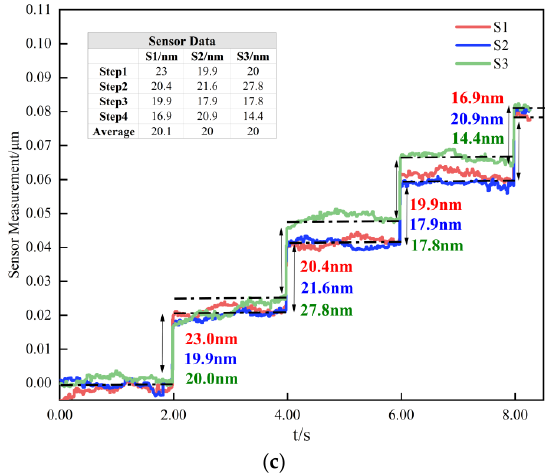
Figure 16. ( a ) Sensor measurement of minimum rotation around X − axis. ( b ) Sensor measurement of minimum rotation around Y − axis. ( c ) Sensor measurement of minimum translation by Z − axis.